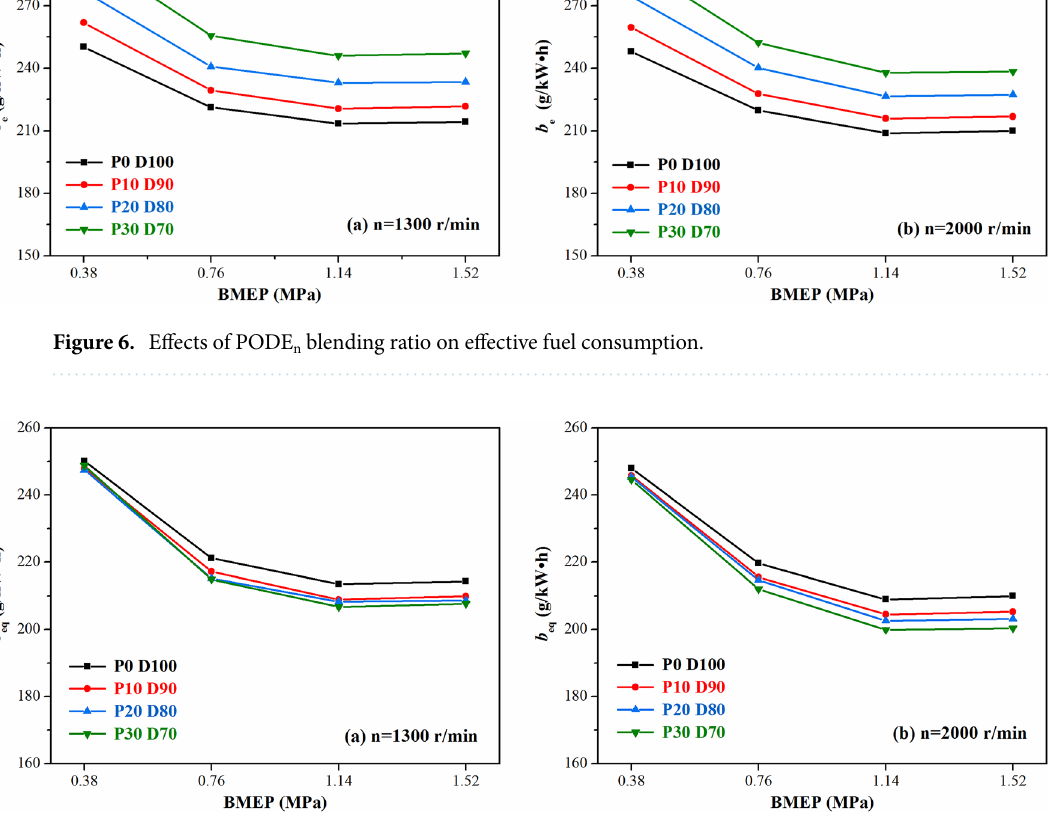
Figure 7. Effects of PODE n blending ratio on equivalent effective fuel